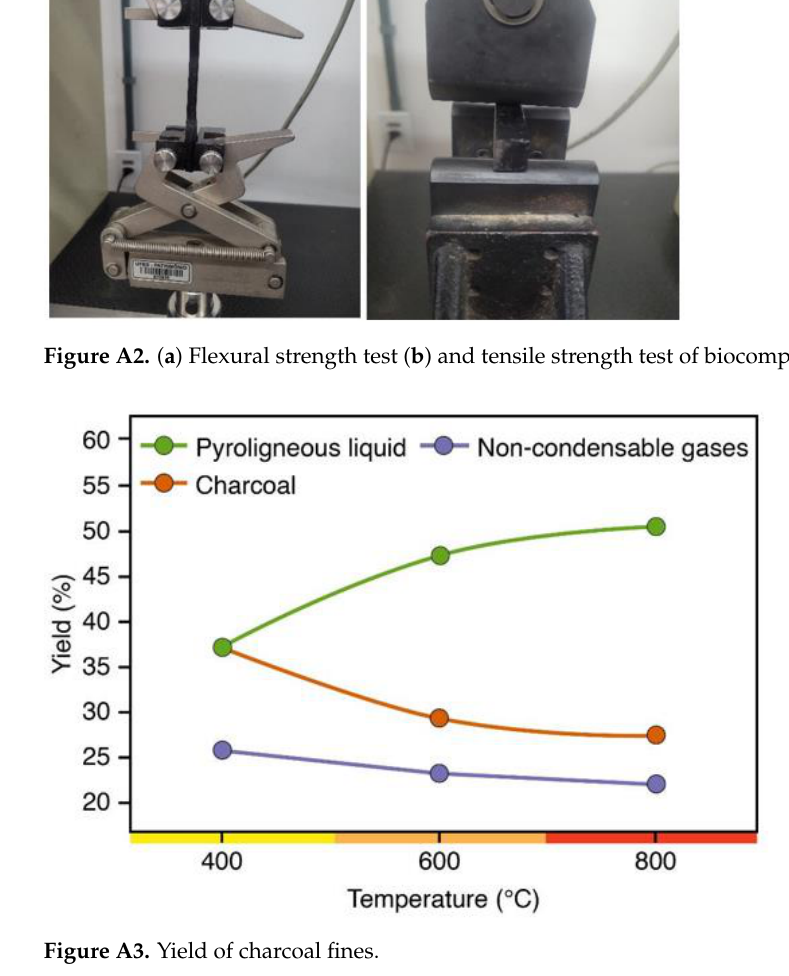
Figure A3. Yield of charcoal fines.